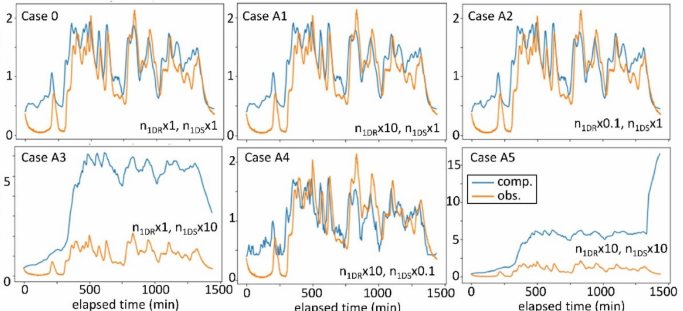
Figure 5. Comparisons of the time-varying water level at the Shin-Yokohama manhole in cases 0, A1, A2, A3, A4 and A5. In the figure, n 1DR and n 1DS are the roughness of the river bed and the pipeline for case 0,